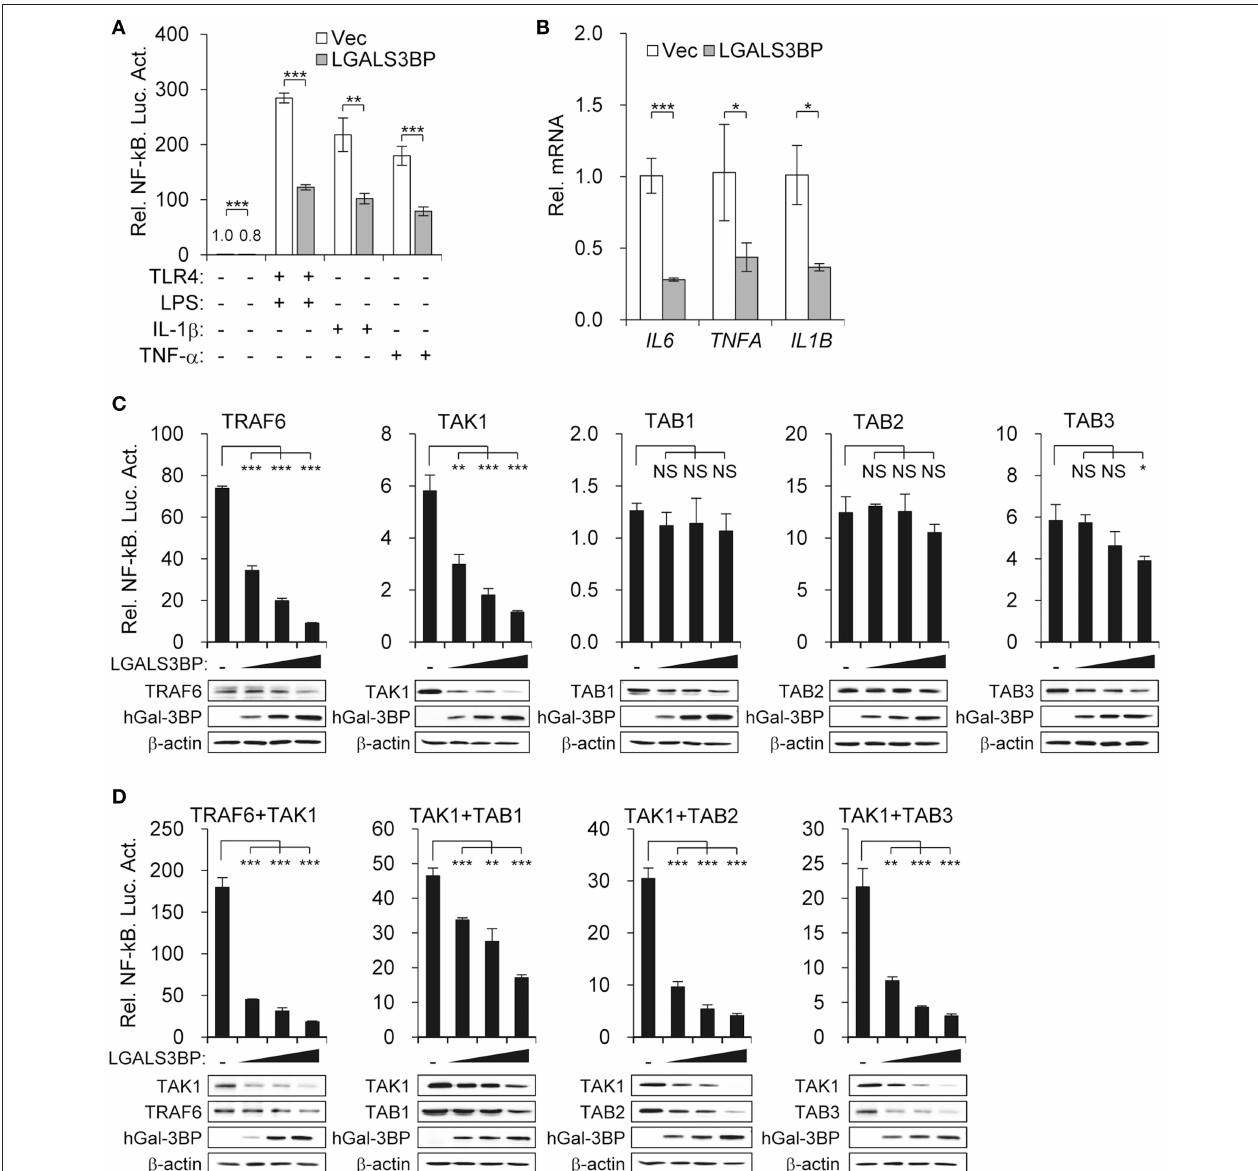
FIGURE 3 | Gal-3BP inhibits TAK1-dependent NF-kB activation. (A) HEK293T cells were transfected with NF- κ B-luciferase reporter plasmid, along with a vector control, LGALS3BP expression plasmid, or TLR4 expression plasmid. After stimulation with LPS, IL-1 β , or TNF- α for 24h, NF- κ B-dependent luciferase activity